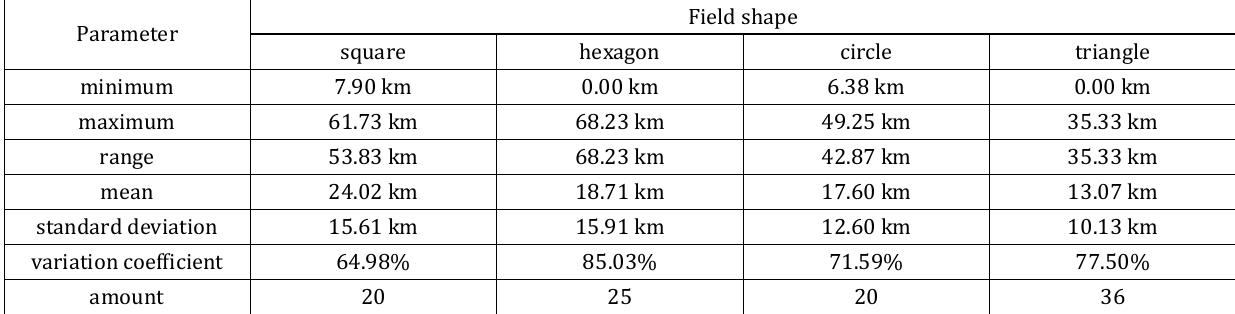
Table 6. Statistical data of basic fields (10